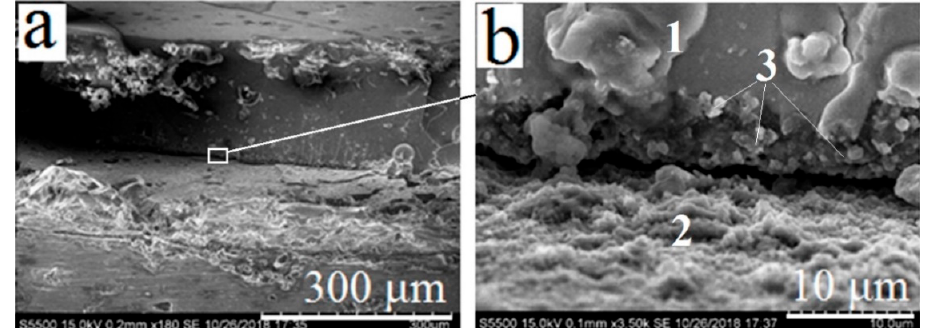
Figure 6. Cross-section of oxidated nonporous titanium samples (series 3) after applying the coating. Phases are marked as follows: 1—glassy PbSiO 3 ; 2—TiO 2 layer; 3—crystallites of PbTiO 3 and SiO 2 . Magnifications: 180 × ( a ), 3500 × ( b ).